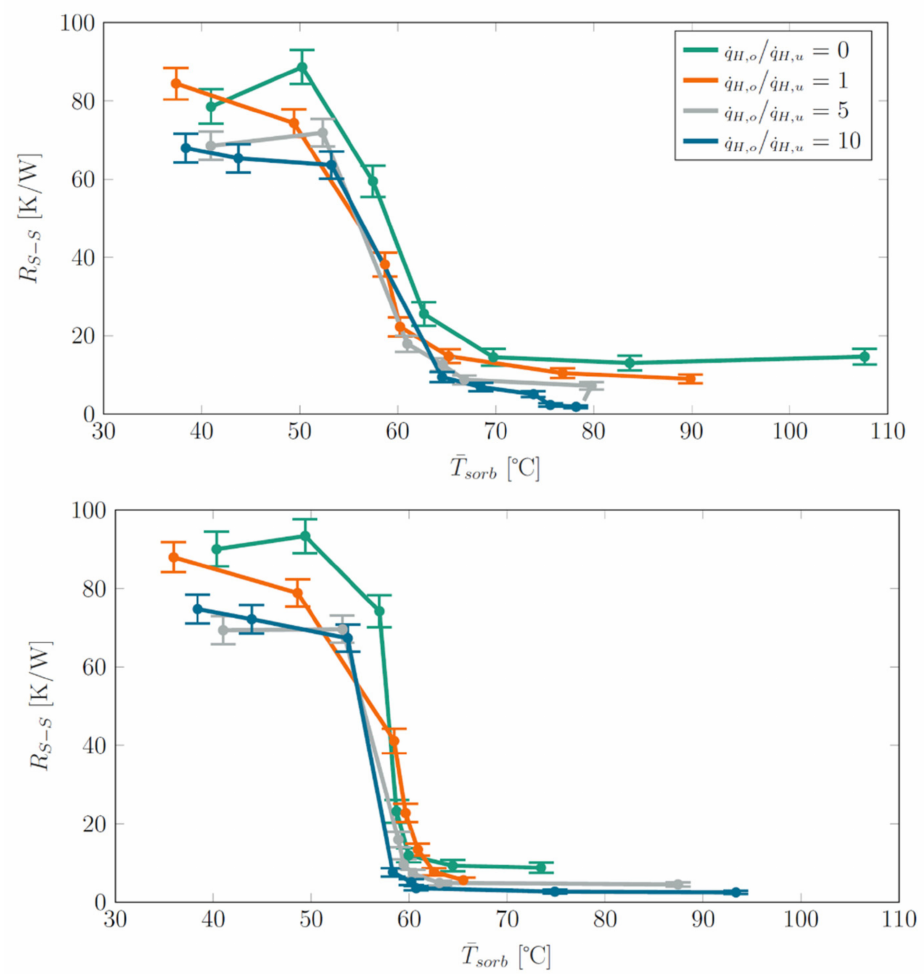
Figure 9. Siphon-2 with sorbent weight of 4 g ( top ) and 6 g ( bottom ): Thermal resistance R S − S vs. average sorbent temperature T sorb for different heat power density rations clarity, only data for R S − S and from the ramp-up phase of heat powers are